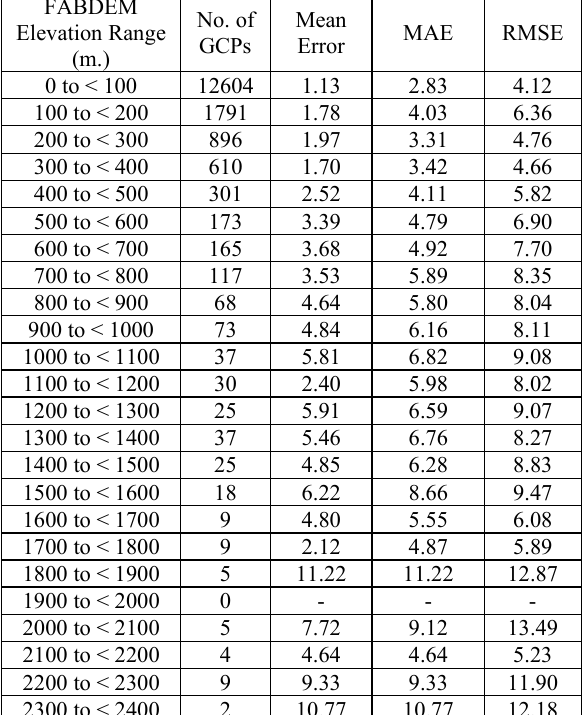
Table 6. The FABDEM accuracy statistics computed using all the GCPs located at varying elevation ranges (unit: meters).